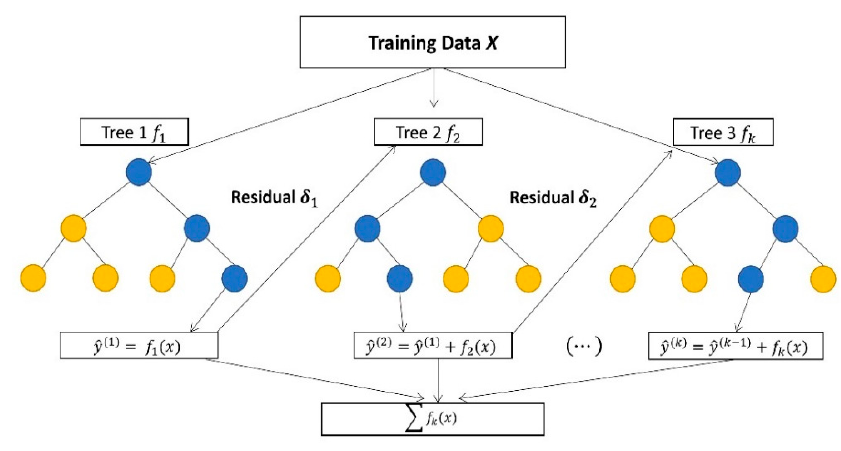
Figure 6. XGBoost Structure.